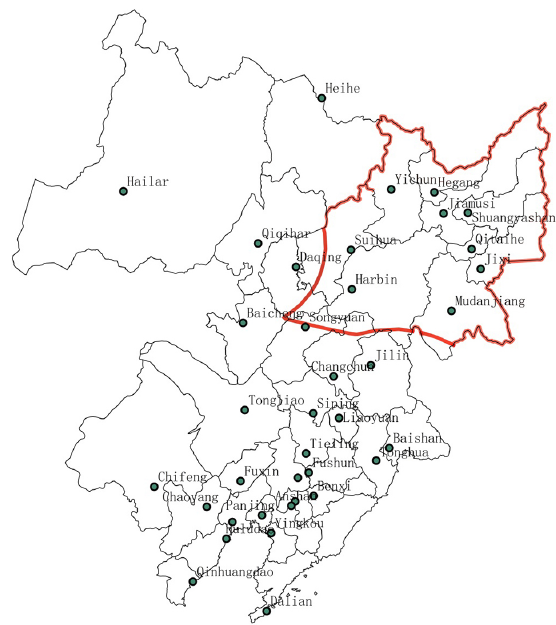
weighted-Voronoi-diagram and break-point